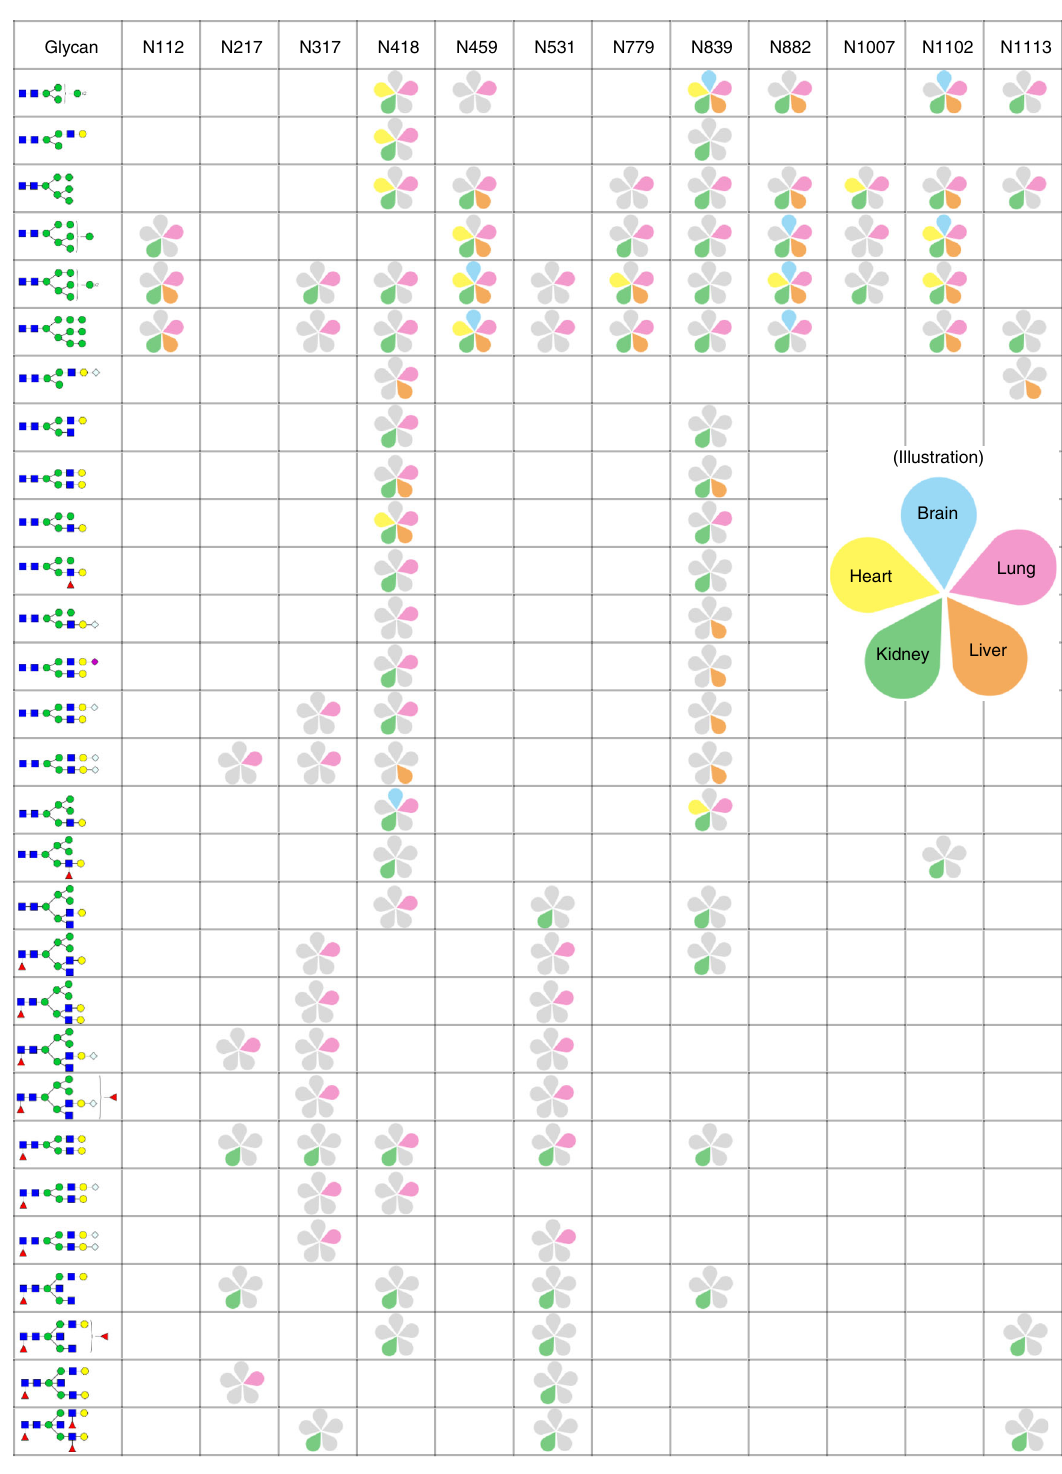
Fig. 8 Analysis of the glycosylation pro fi le of protein Q3V3R4 (integrin alpha-1) in fi ve mouse tissues. The glycosylation sites are listed in the fi rst row, and the glycans are listed in the fi rst column. The identi fi ed site-speci fi c glycans are shown as a petal-shaped mini fi gure inside the block to demonstrate the tissue speci fi